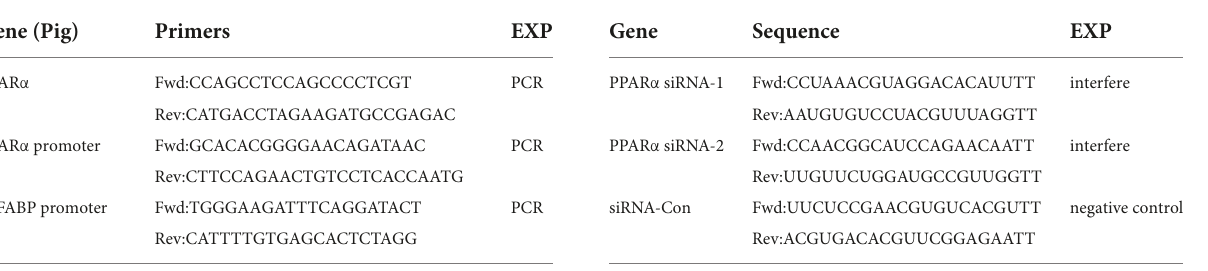
TABLE 1 Primers or oligonucleotides for PCR. TABLE 2 siRNA interference